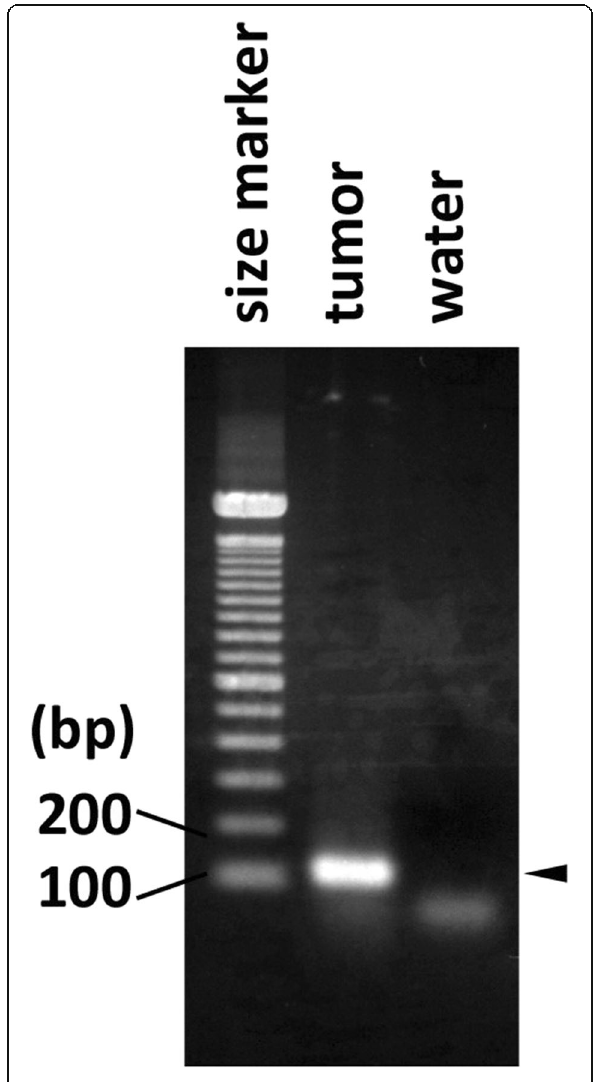
Fig. 6 RT-PCR findings. Identification of the parathyroid hormone transcript in tumor RNA by RT-PCR. RNA extracted from the tumor and water was subjected to RT-PCR analysis for PTH transcript detection as described in the Materials and Methods section. The arrowhead on the right side indicates the band from the tumor sample that almost corresponds to the predicted PCR product size of 103 base